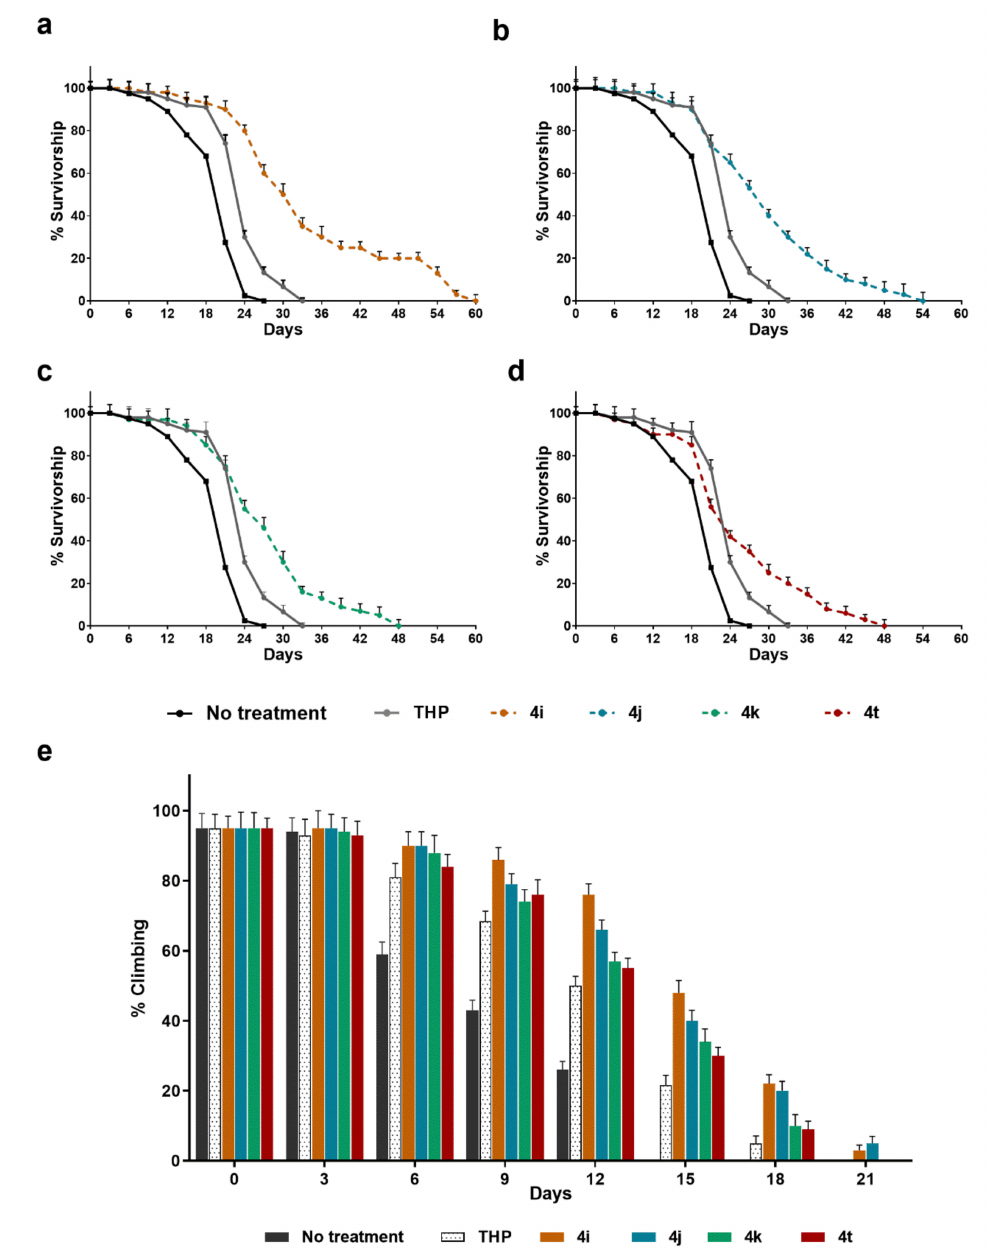
Figure 6. The e ff ects of THP-derived molecules 4i , 4j , 4k , and 4t on fly lifespan and motor dysfunction. ( a – d ) Lifespan curves of transgenic UAS-Q128HD-FL / Elav-GAL4 flies fed with diets supplemented with the tested molecules. For each molecule, the comparison of age-dependent survival curves was done both with respect to the solvent alone and to THP. All treated groups had increased lifespans compared to both the control group and the THP group. ( a ) A longer extension in survival with respect to THP was observed in response to 4i , ( p < 0.001), with a 44.95% increase in the mean lifespan. ( b ) A dramatic comparable increase was obtained after treatment with 4j ( p < 0.001), with an increase in the mean lifespan of 25.3%. ( c ) A moderate but highly significant increase in survival was observed in response to 4k ( p < 0.001; mean lifespan + 16.96%). ( d ) A minor increase in survival, although highly significant, was observed in response to 4t ( p < 0.01; mean lifespan + 9.18%). n = 100 flies. ( e ) The climbing ability of UAS-Q128HD-FL / Elav-GAL4 transgenic flies fed with di ff erent media supplemented with one of four di ff erent derived-THP molecules, with THP, or with vehicle alone for control, was evaluated. All the tested THP-derived molecules improved the climbing ability of transgenic flies. The data are given as the mean ± SD. n = 60. p < 0.001 compared with THP for 4j , 4i , 4k , and 4t